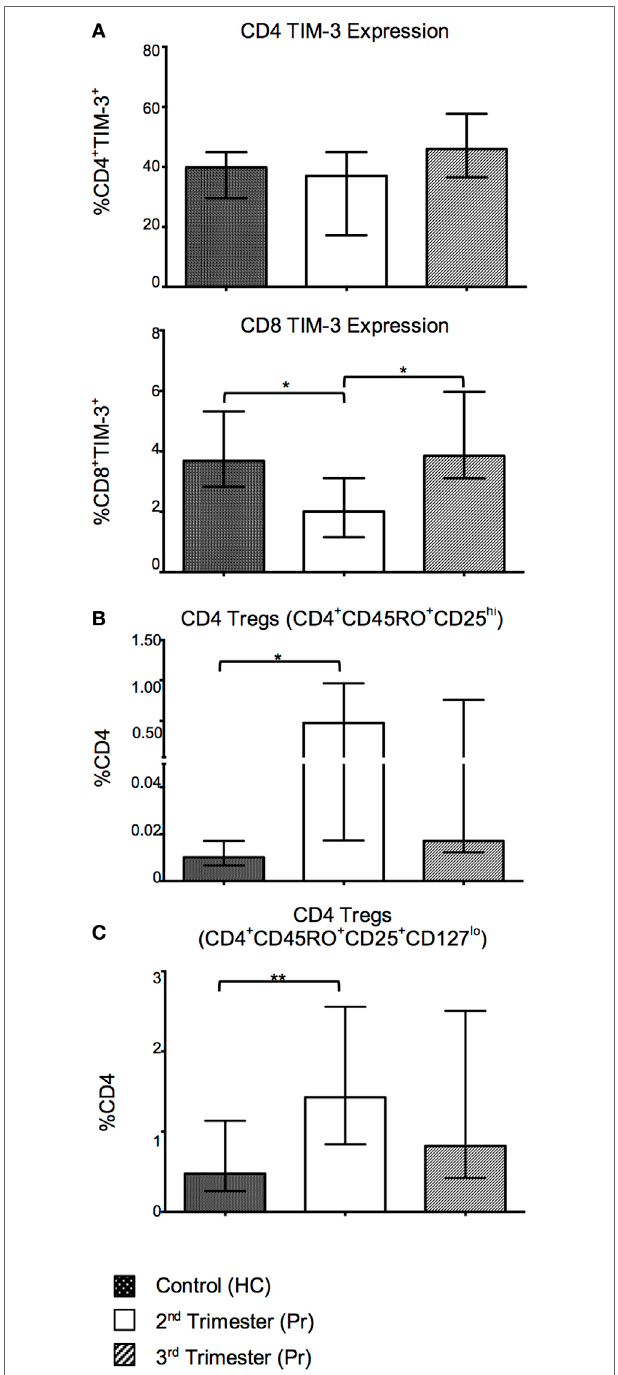
FigUre 4 | Tolerant T-cell phenotypes are favored in pregnancy and reflect changes in T-cell activation with increasing gestation. (a) Percentage expression of CTLA-4 on TIM-3 negative and positive, CD4 and CD8 T cells in pregnancy compared with controls. (B,c) Proportions of CD4 regulatory T cells (Tregs) in pregnancy. These cells were identified using the phenotype CD4 + CD45RO + CD25 hi and CD4 + CD45RO + CD25 + CD127 lo . * p < 0.05 and ** p < 0.01. Columns indicate median and error bars interquartile range. * p < 0.05 and ** p < 0.01 (Mann–Whitney U ). Abbreviation: HC, health control; Pr,